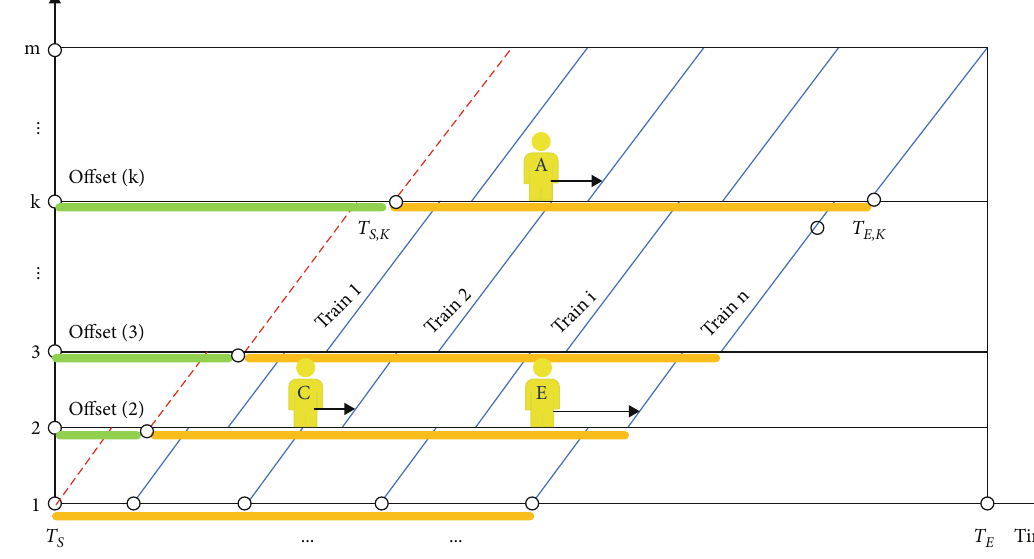
Figure 1: Illustration of the time range studied at di ff erent stations.